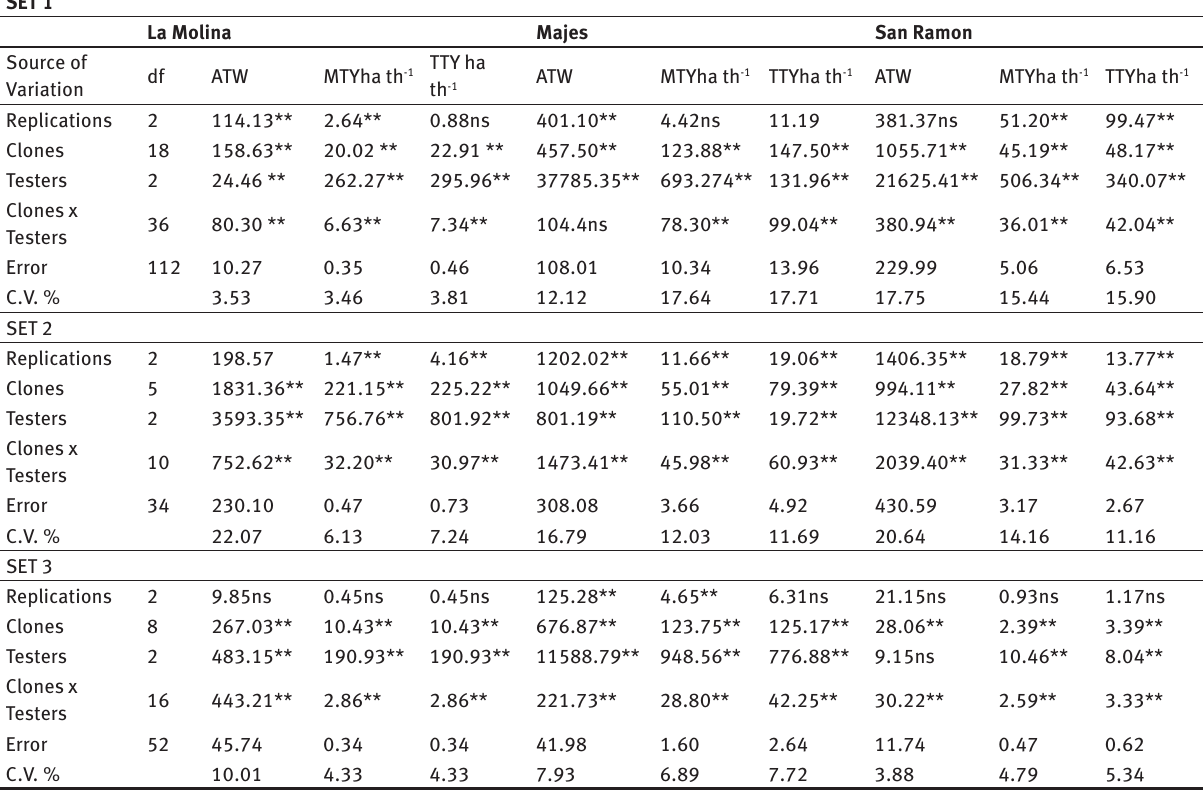
Table 4: Analysis of variance of three sets in three sites for ATW, MTYha and TTYha SET